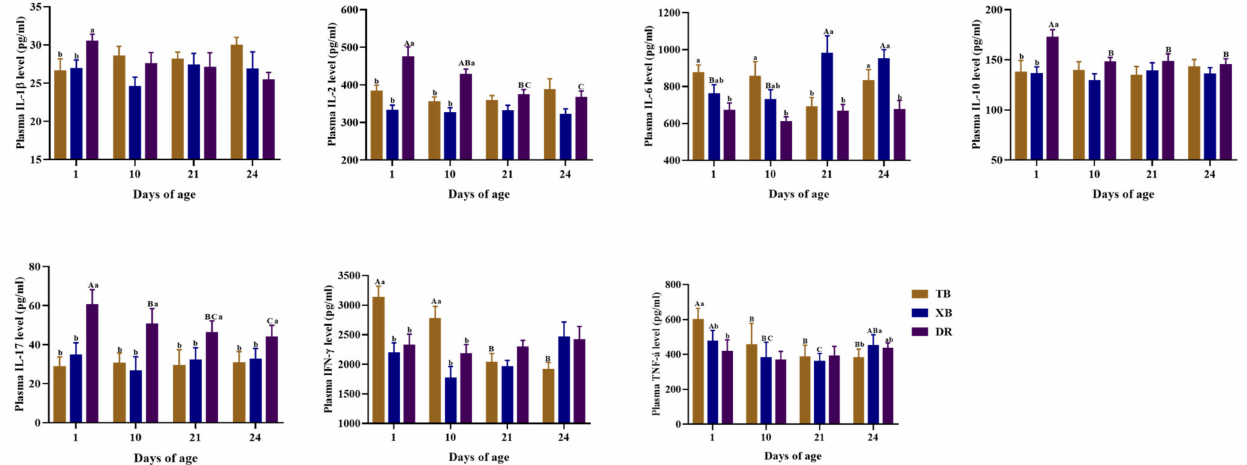
Figure 2. Changes in plasma immuno-cytokine levels of different pig breeds during suckling and weaning periods. Data are presented as means with their pooled SEM ( n = 10). Different capital letters (A, B, and C) indicate significant differences between ages in the same breed ( p < 0.05), and different small letters (a and b) indicate significant differences between breeds at the same day of age ( p < 0.05). IL, interleukin; IFN, interferon; TNF, tumor necrosis factor; DR, Duroc piglet; TB, Taoyuan black piglet; XB, Xiangcun black